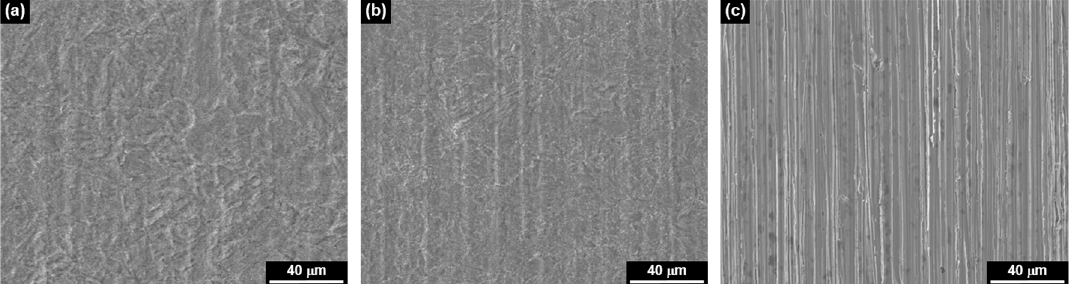
Figure 4. SEM micrographs showing the corroded surfaces of SA508 after polarization scans at ( a ) the